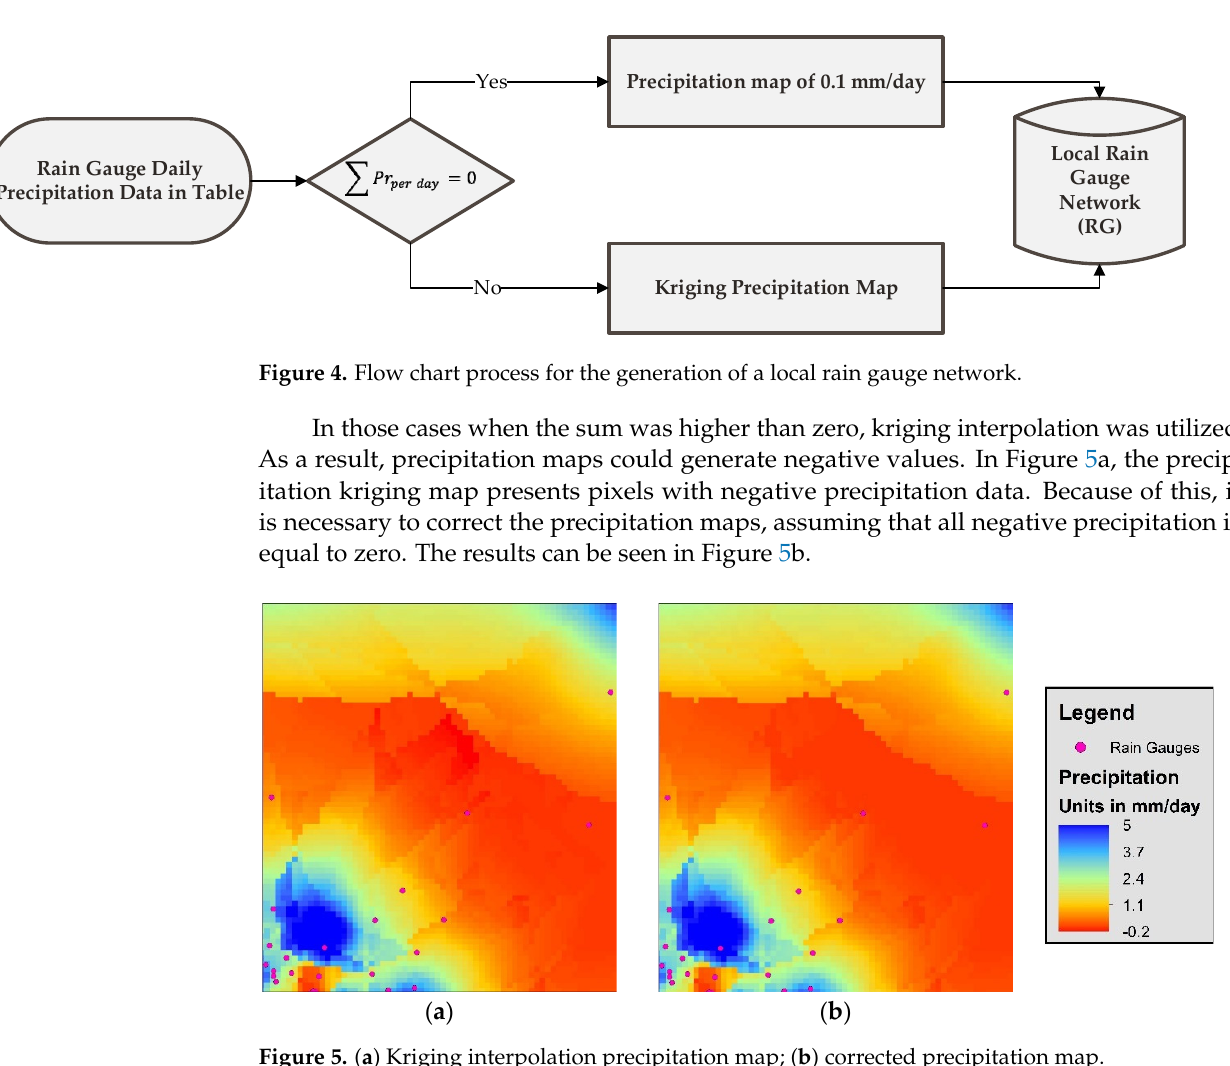
Figure 5. ( a ) Kriging interpolation precipitation map; ( b ) corrected precipitation